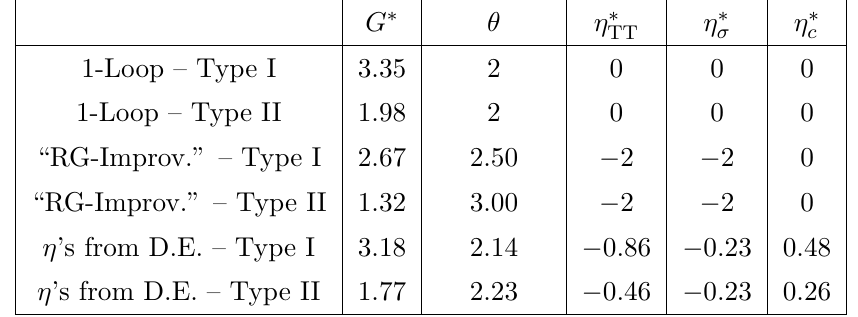
Table 2 . Fixed point structure associated with the case ~ m 2 results obtained using both types of coarse-graining operators and for the di(cid:11)erent approximations concerning the anomalous